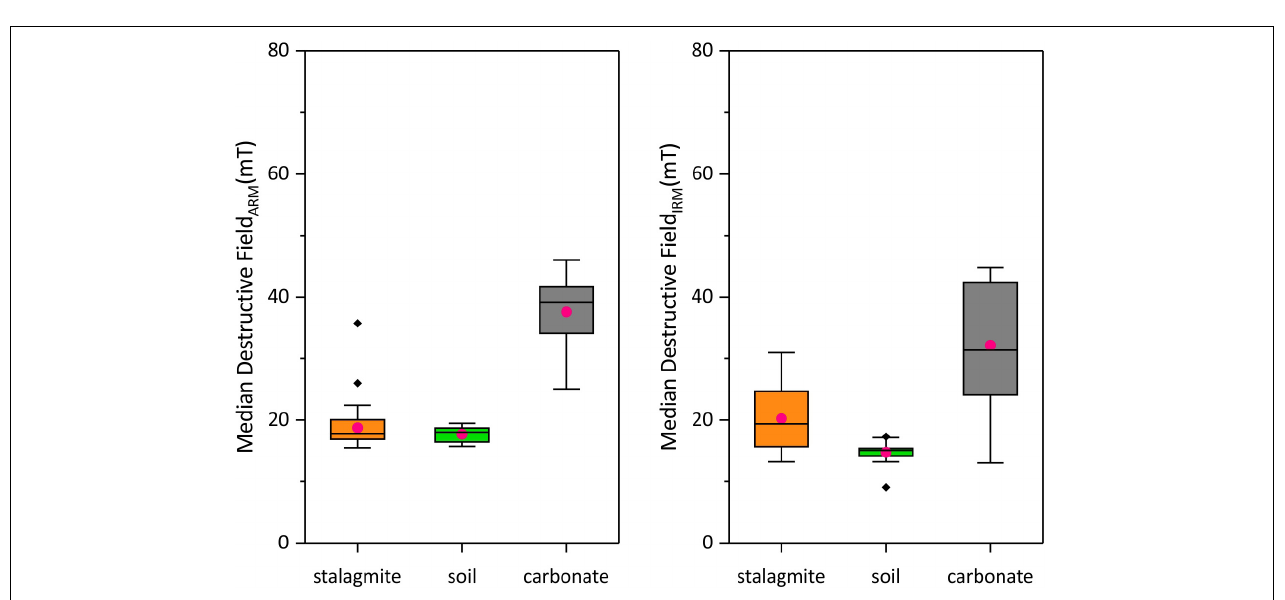
FIGURE 5 | Environmental magnetic parameters showing the fraction of remanence held by grains with coercivities < 300 mT (S-ratio) and the remanence held by high-coercivity minerals (HIRM) for stalagmites (orange), carbonates (gray), and soil (green).